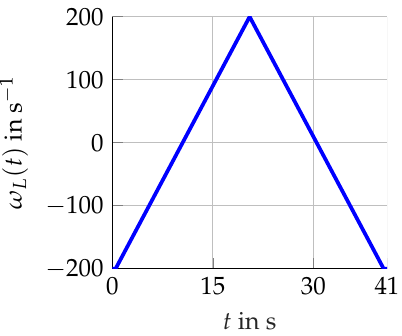
Figure 6. Scenario B for a slowly changing ω L ( t ) (revolutions per second).